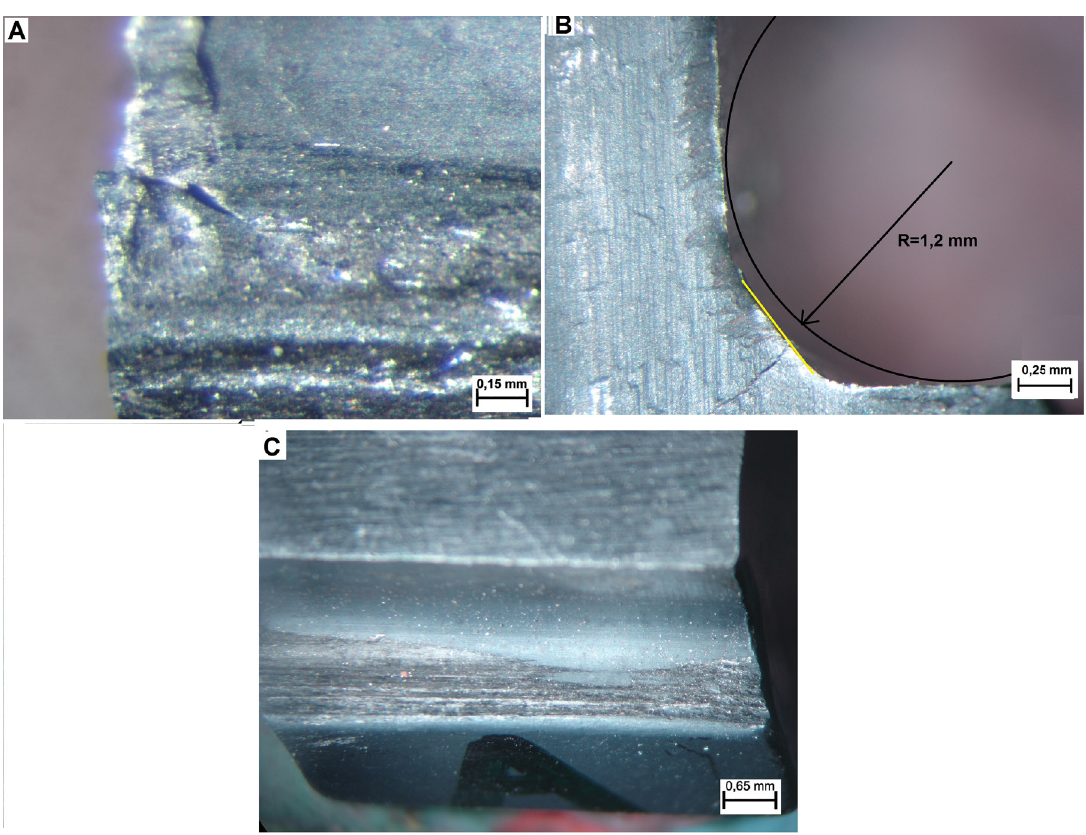
Figure 10. (A) Detail with higher magnification of the region shown in Figure 7 . (B) The concave face view (yellow lines) of Figure 10B , where a curvature radius of approximately 1.2 mm has been simulated (part design, .stress raiser level (yellow line) . (D) Curvature radius stereography at the base of the P3